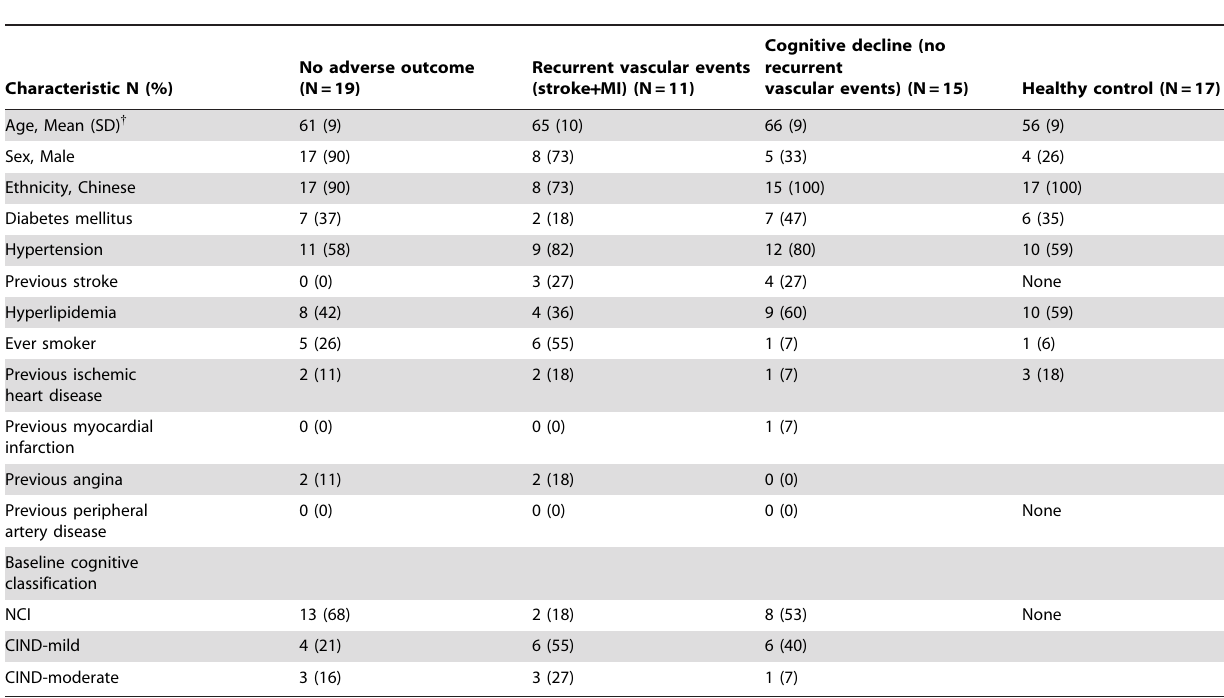
Table 1. Demographic Characteristics of the Patient Population Stratified by the Outcome Measures.